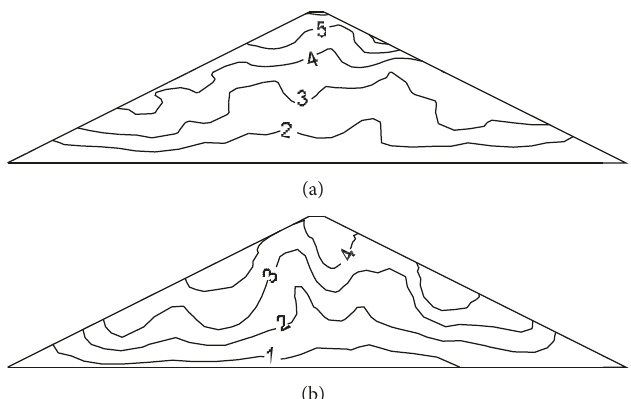
Figure 17: Acceleration distribution for Scheme 1 (unit: m/s 2 ): (a) horizontal and (b) vertical.